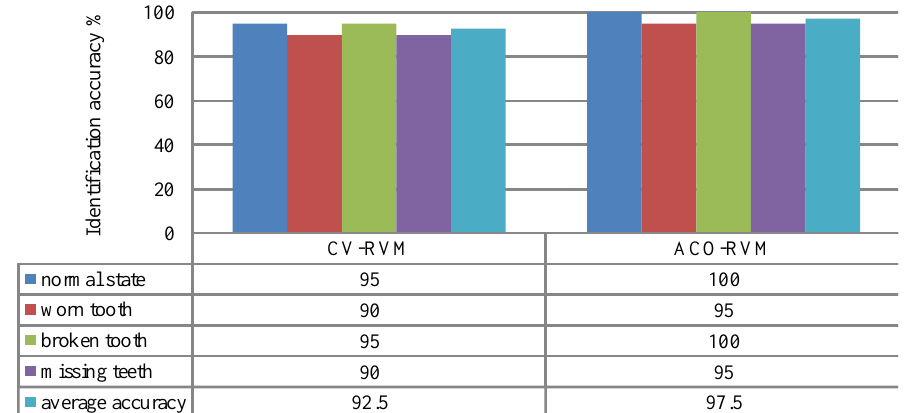
Figure 11. Comparisons of identification accuracy between the CV-RVM classifier and the ACO-RVM classifier in the bevel gearbox test. * The parameter  of the RVM based